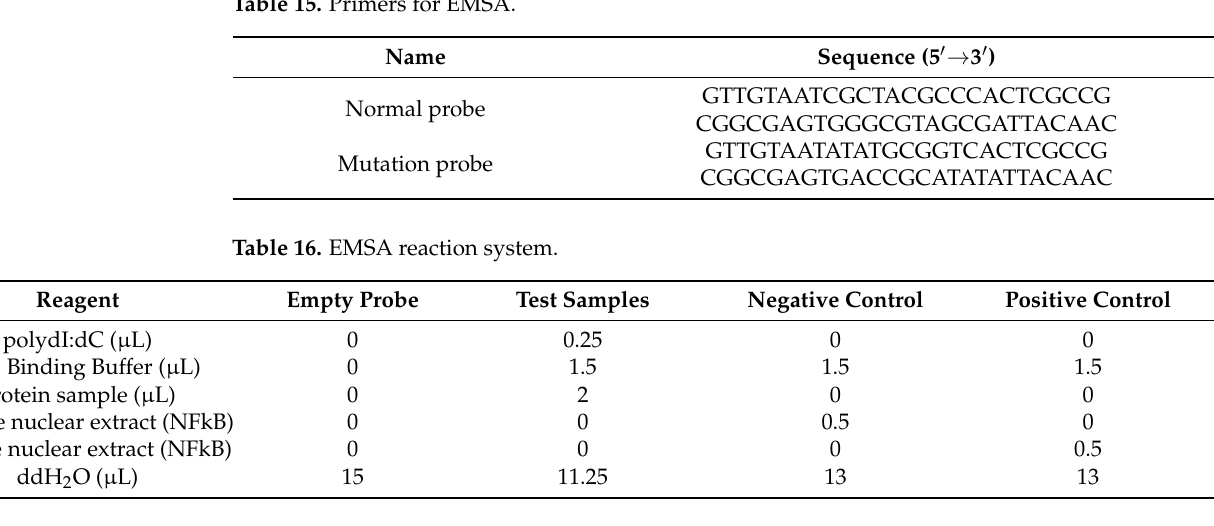
Table 17. Cold competitive EMSA reaction